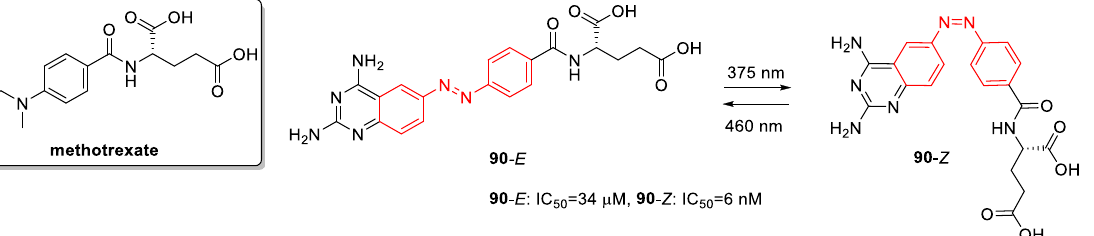
Figure 15. Photoswitchable methotrexate analog, the photoswitch unit indicated in